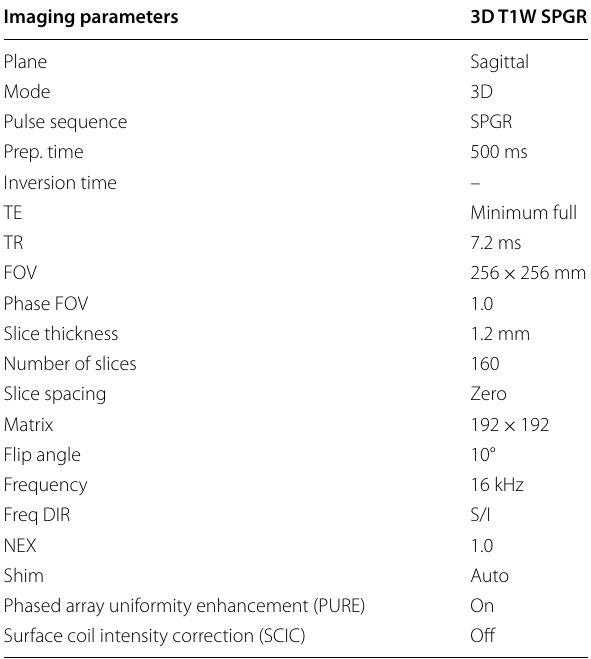
Table 1 Imaging parameters used for acquiring 3D T1W sequence Imaging